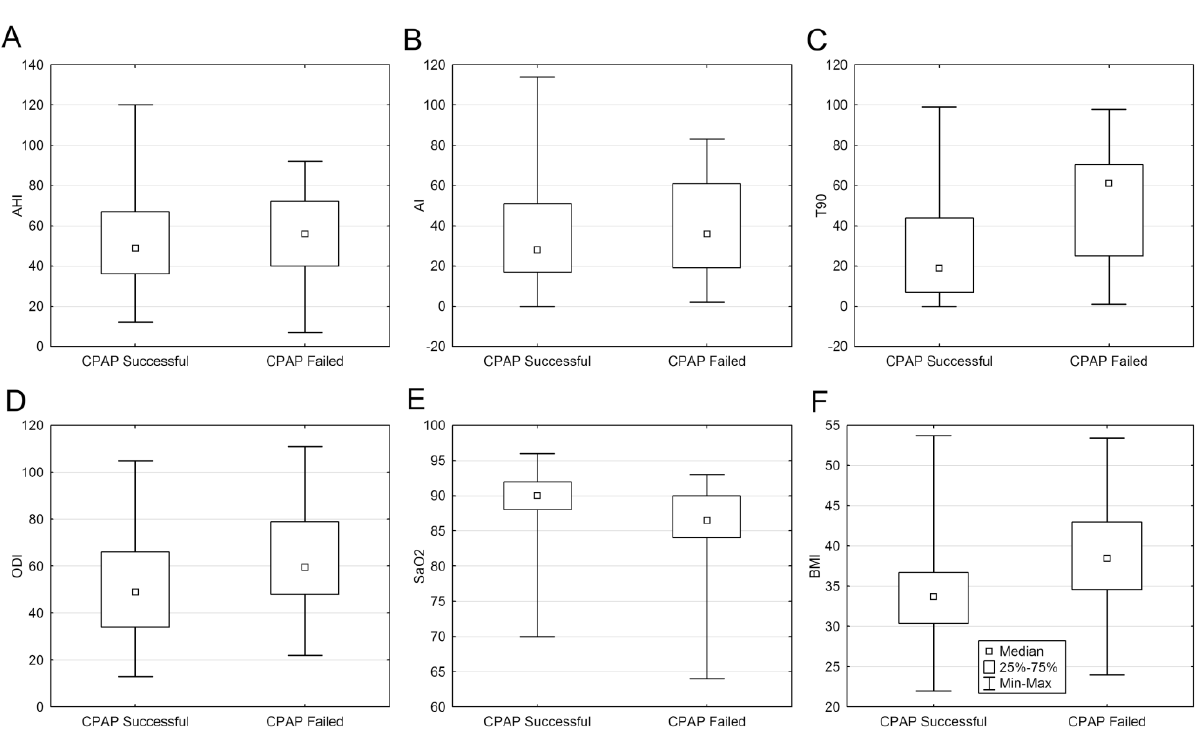
Fig. 1. Comparison of the monitored variables between the patients with successful and unsuccessful CPAP therapy. A – AHI, B – AI, C – T90, D – ODI, E – SaO2, F – BMI.